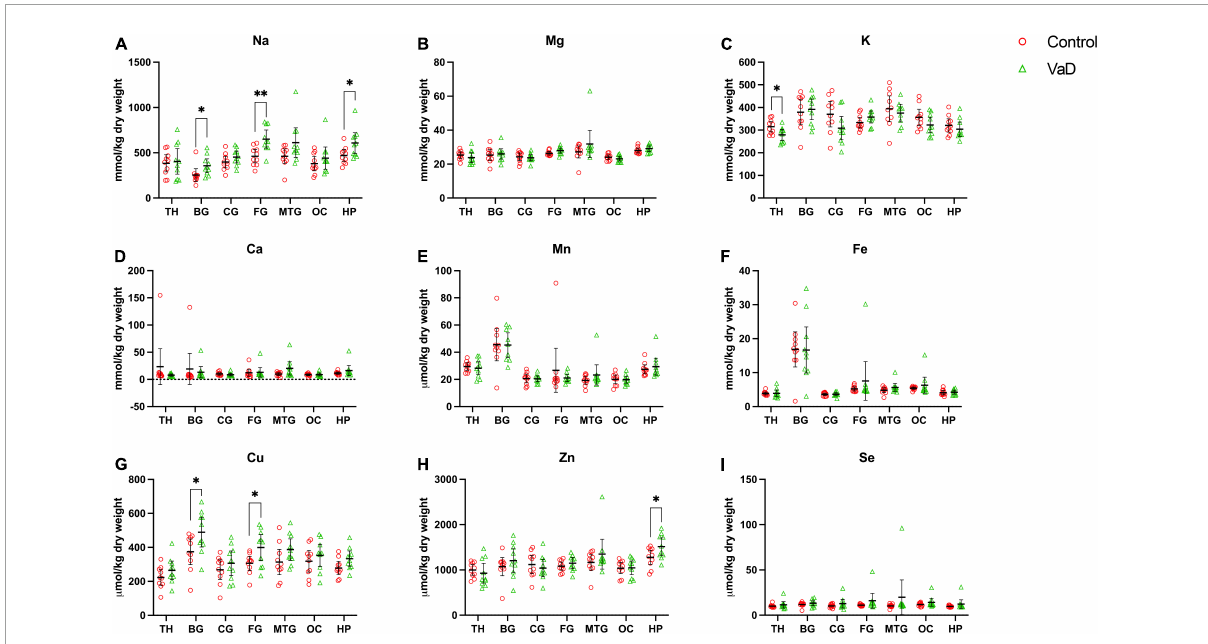
FIGURE2 Dry-weight concentrations of nine essential metals (A–I) in seven brain regions compared between control (red) and VaD (green) post-mortem tissue. Data are means ± 95% CI. TH, thalamus; BG, basal ganglia; CG, cingulate gyrus; FG, frontal gyrus; MTG, middle temporal gyrus; OC, occipital cortex; HP, hippocampus. * p < 0.05, ** p < 0.01, and *** p <